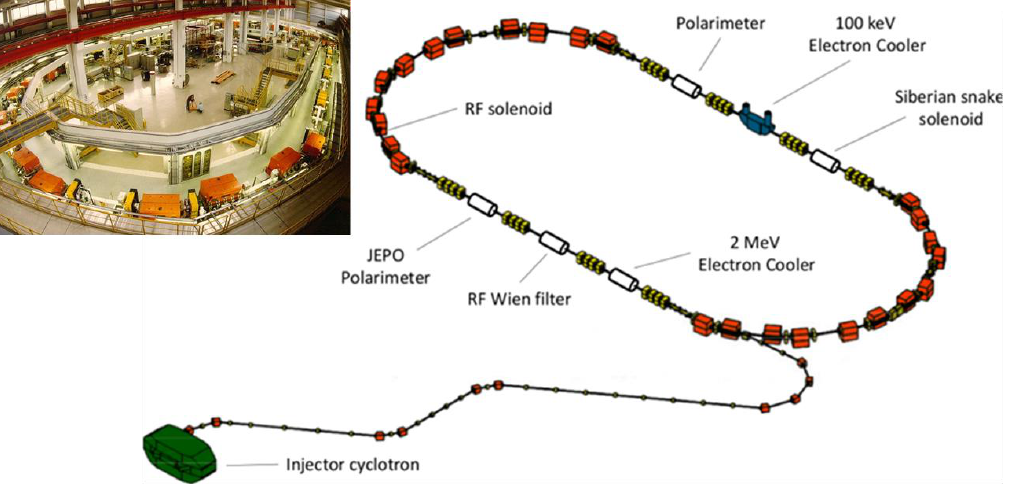
Figure 6. Layout of the Cooler Synchrotron (COSY) storage ring at Forschungszentrum Jülich (Germany) together with an early photograph: the ring has a circumference of 184 m and can accelerate and store unpolarized and polarized beams of protons and deuterons from the injector cyclotron with momenta up to 3.7 GeV/c. The equipment comprises electron and stochastic cooling apparatuses, as well as spin manipulation and detection devices. The unique capabilities of COSY have been used by the JEDI collaboration to investigate manipulations of polarized particle beams and its response to external electric and magnetic fields as preparation for EDM measurements—both at COSY and future dedicated storage rings.